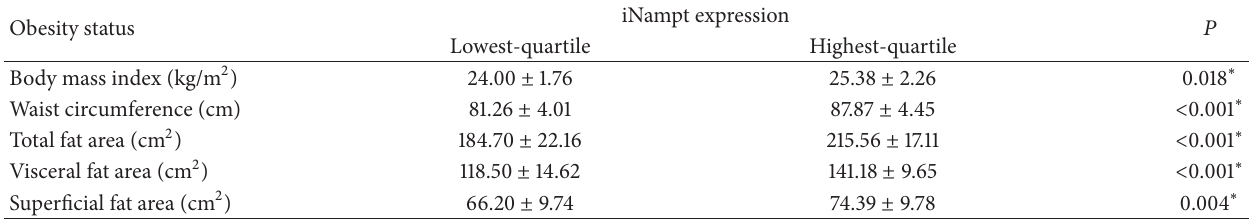
Table 3: Differences in obesity status between tumors with lowest- versus highest-quartile iNampt expression.